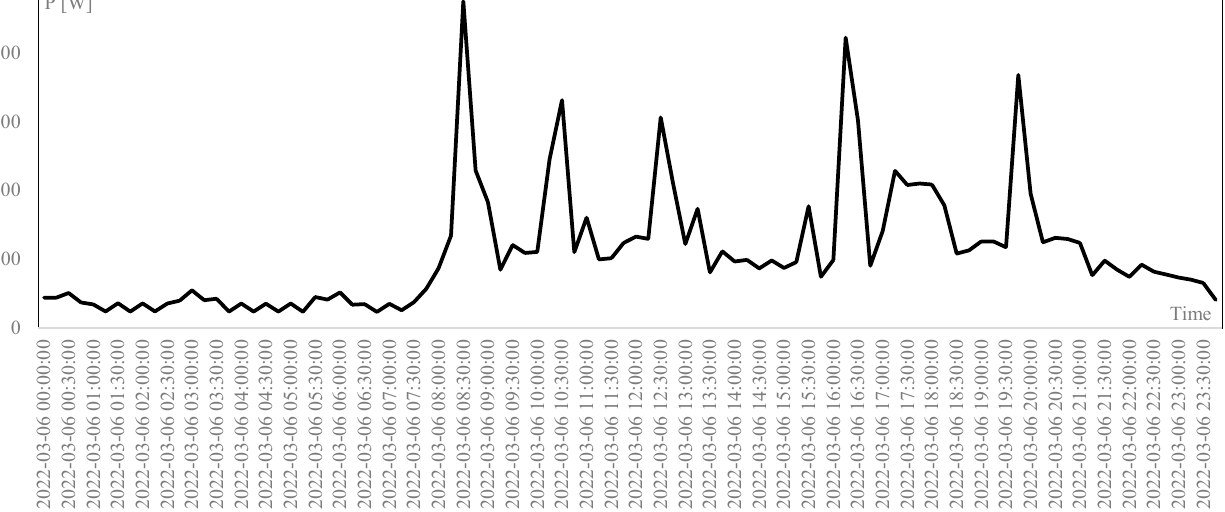
Figure 12. Load power profile.